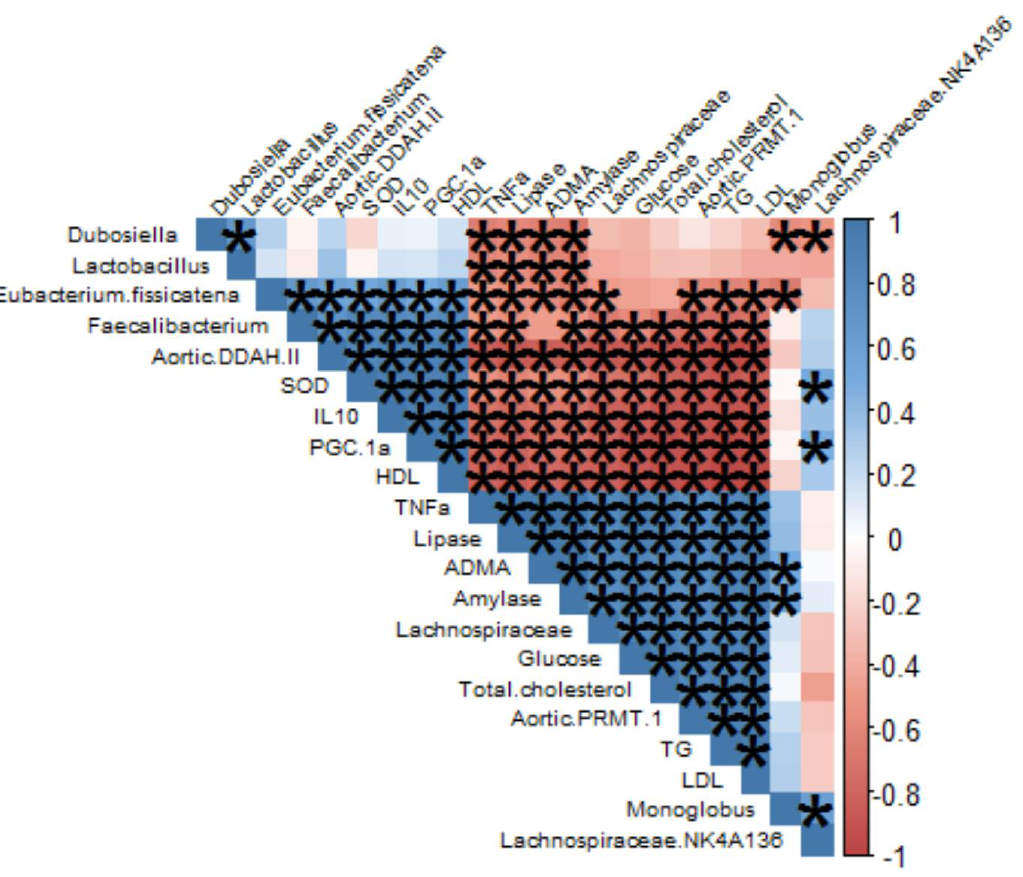
Figure 5. Heatmap of Pearson correlation between the gut microbiome and blood metabolic profiles of mice. The asterisks inside the heatmap indicate p < 0.01.